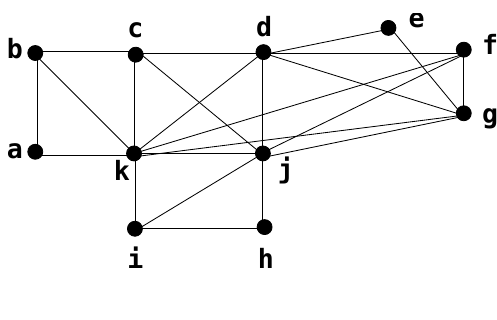
Figure 4. Chordal graph H , with minimal separators: { b; k } ; { c; k } ; { d; j; k } ; { j; k } ; { i; j }